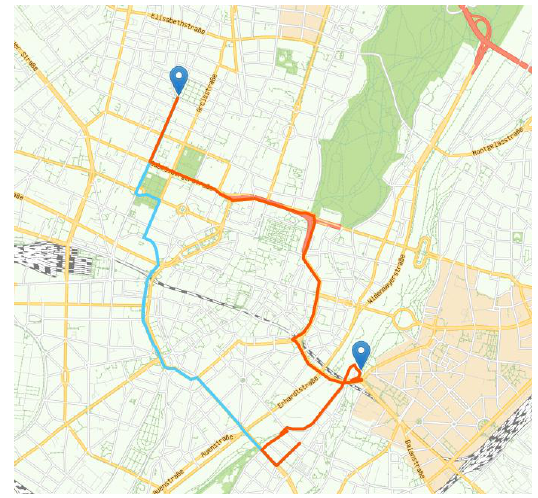
Figure 5. Result of Multimodal Route